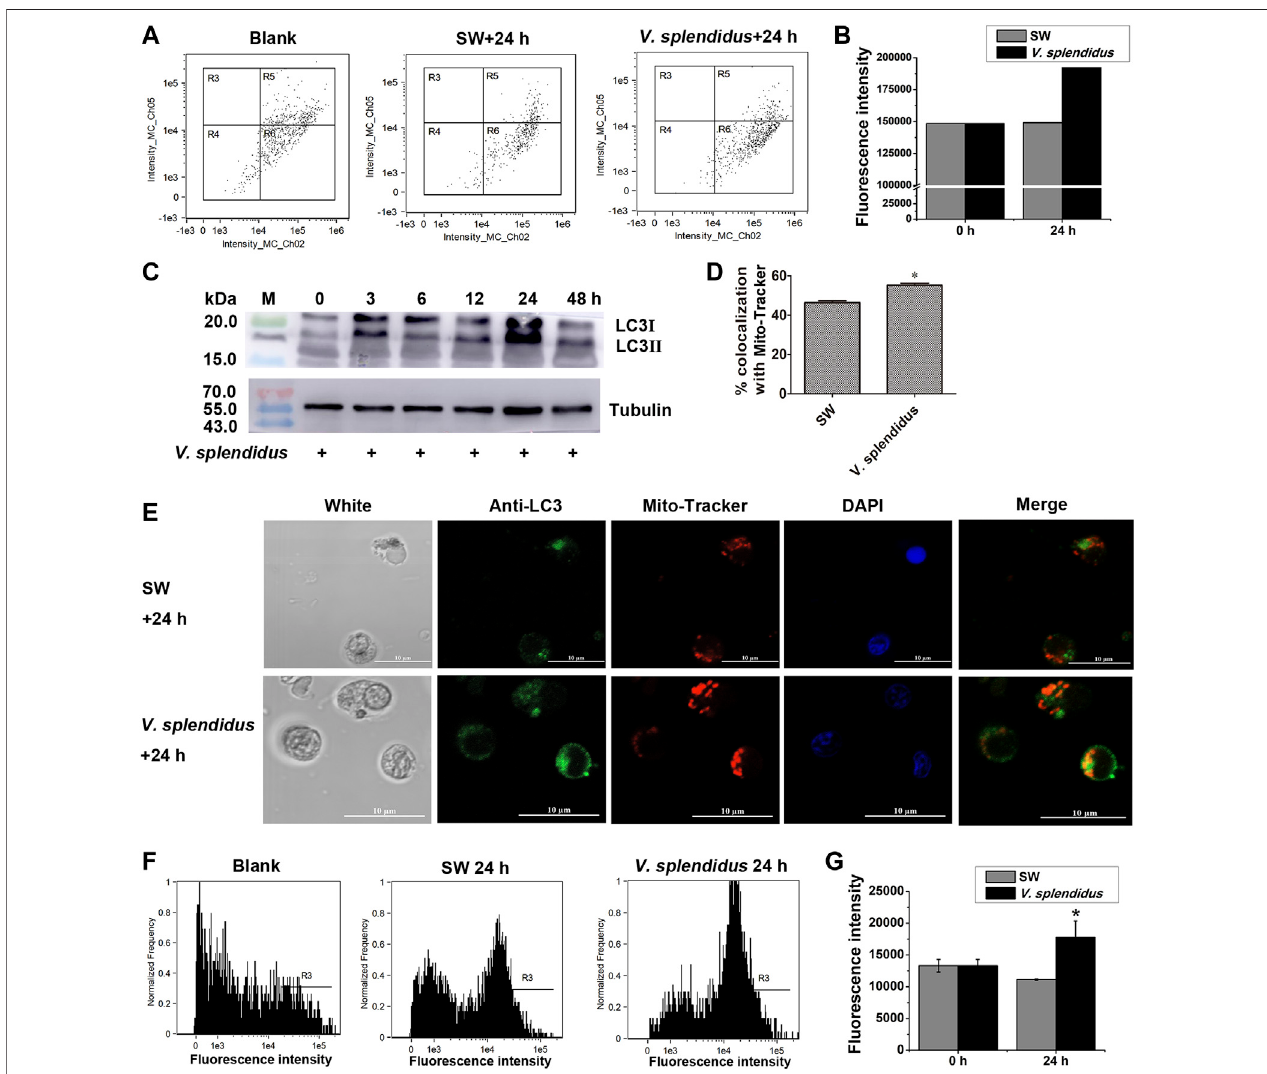
FIGURE 7 | Mitochondrial membrane potential, autophagy, Cg LC3 activation, and co-localization of Cg LC3 with mitochondria after V. splendidus stimulation. (A) Mitochondrial membrane potential in hemocytes at 24 h after V. splendidus stimulation analyzed by fl ow cytometry. SW was used as the control. R6: Only green fl uorescence of JC-1 monomers (a marker of mitochondrial autophagy). (B) Statistical analysis of JC-1 monomer green signals for (A). (C) Cleavage of Cg LC3B in hemocytesat0,3,6,12,24,and48 hafter V.splendidus stimulation.Tubulinwasusedasaninternalcontrol. (D) Quantityof Cg LC3co-localizedwithmitochondria in hemocytes after V. splendidus stimulation. (E) Co-localization of Cg LC3 with mitochondria in hemocytes at 24 h after V. splendidus stimulation. The fl uorescence signalswerecapturedunderthesameexposureparameters. (F) Autophagyinhemocytesat24 hafter V.splendidus stimulation.ThehemocyteswerelabeledbyCYTO- ID ® Greenreagentandanalyzedby fl owcytometry.R3:thecellswithgreensignals. (G) Statisticalanalysisofautophagygreensignalsfor (F) .Theverticalbarsareshown as mean ± S.D. (N = 3). *: p < 0.05 ( t -test).